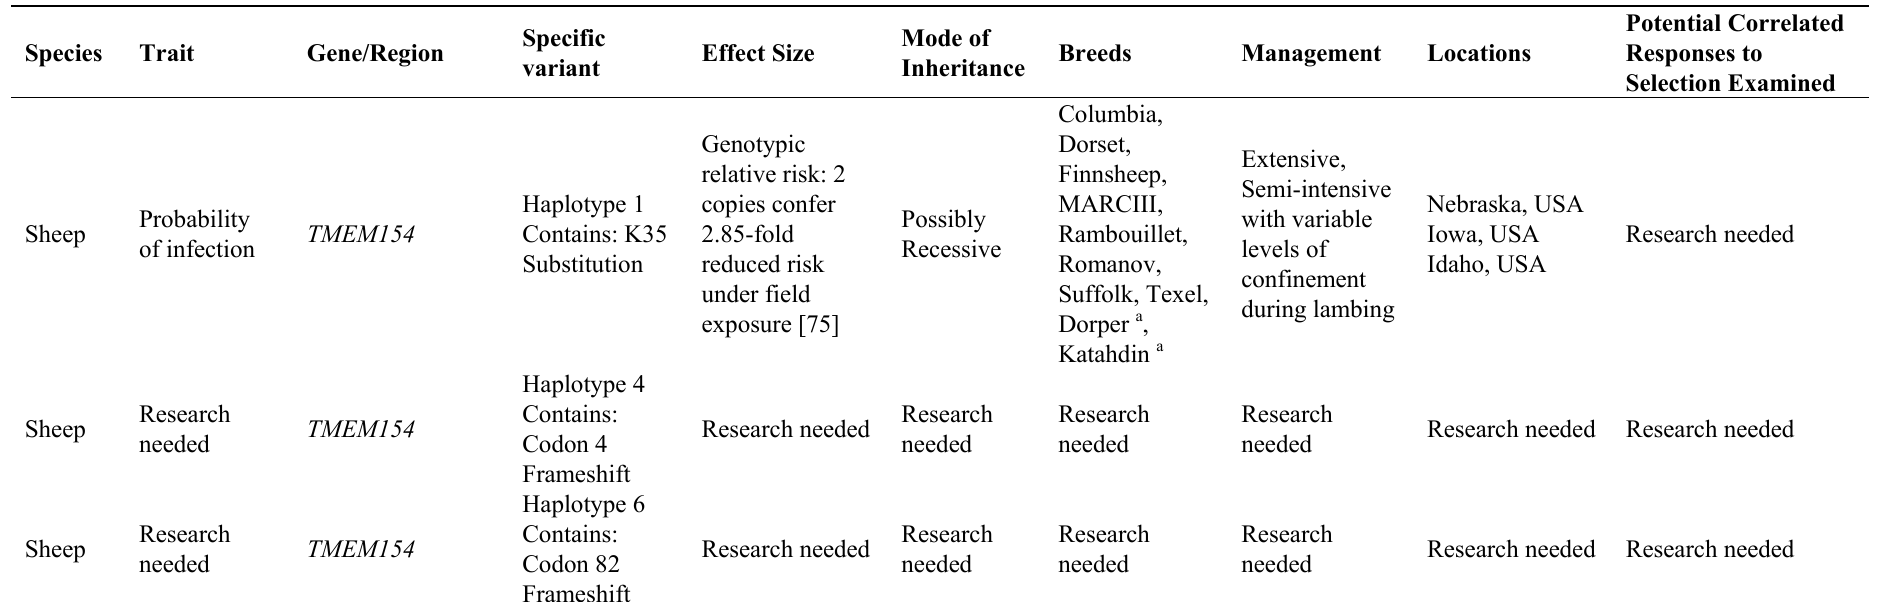
Table 3. Current genetic marker test for small ruminant lentivirus